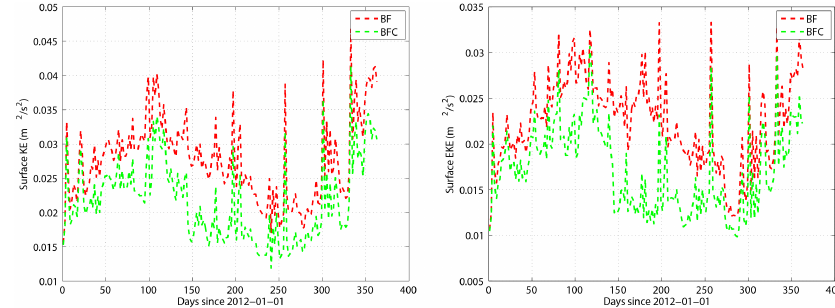
Figure 6. Total (left) and turbulent kinetic energy at surface. Red curve is for BF and green for BFC